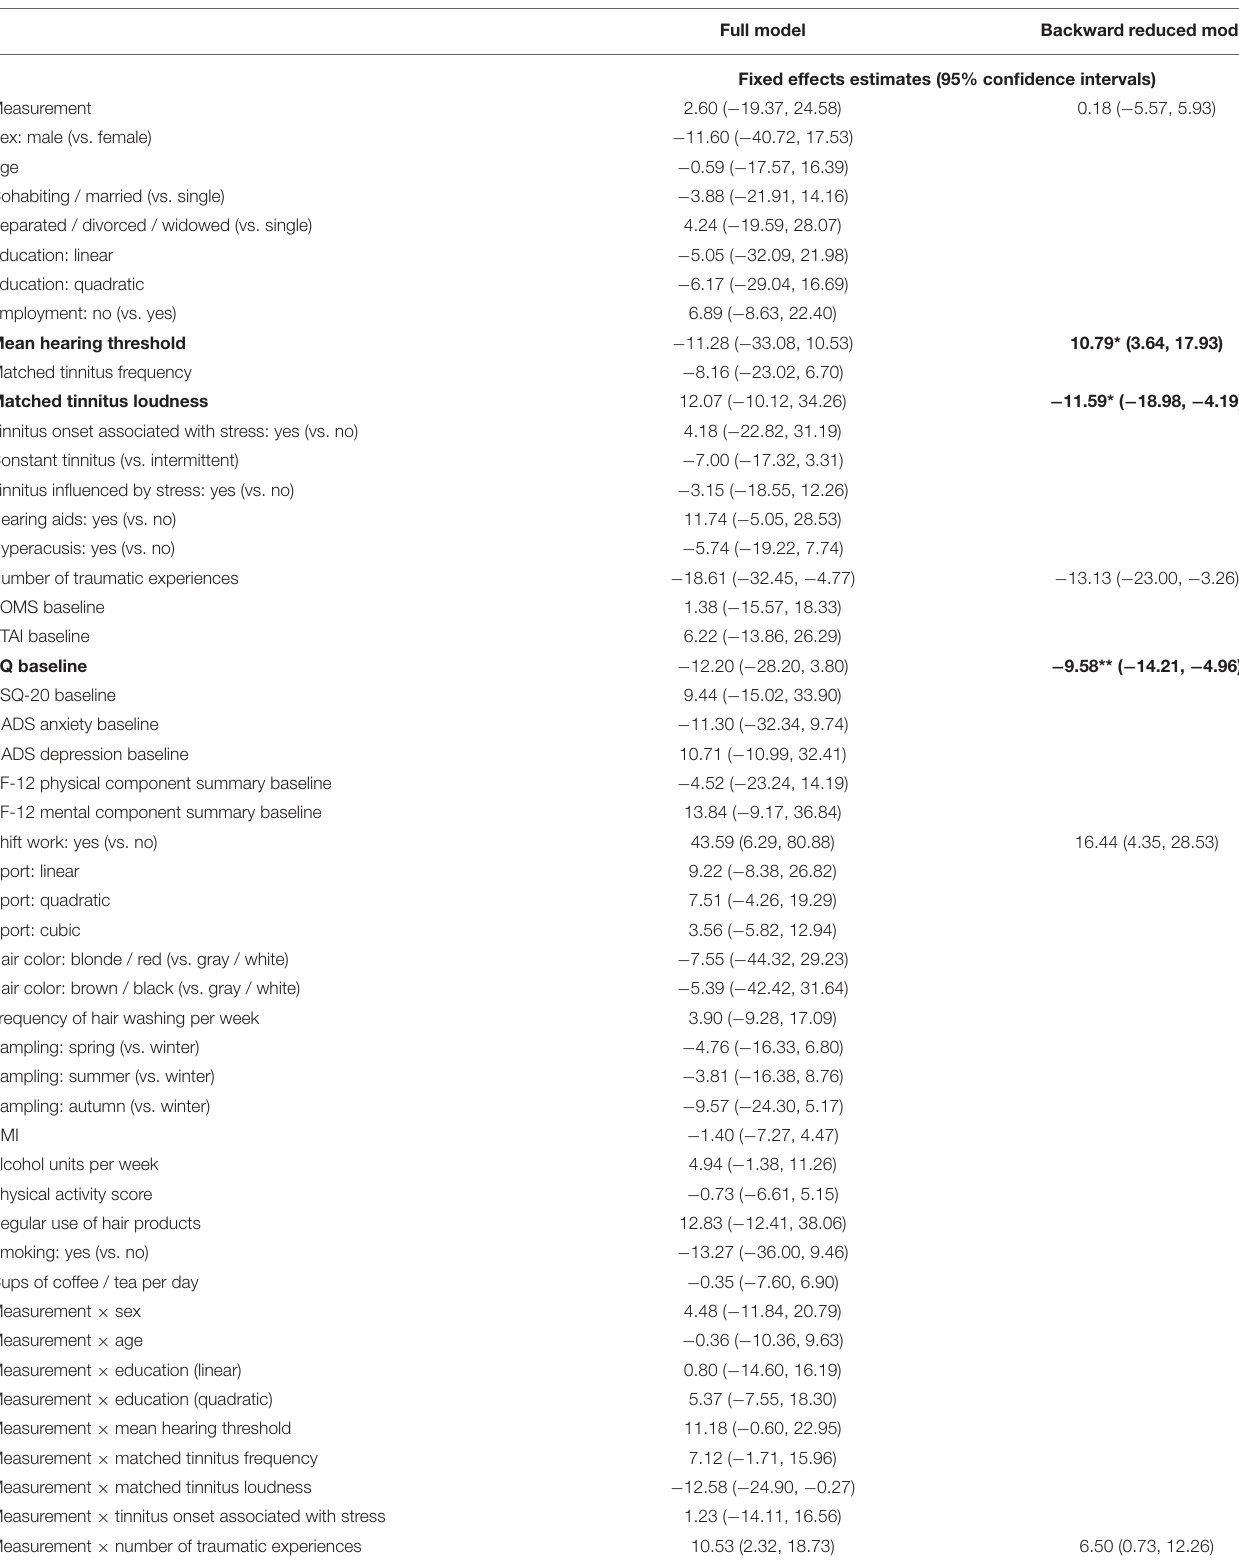
TABLE 6 | Full and backward reduced linear mixed-effects models for change in hair-BDNF levels across baseline and follow-up ( N =